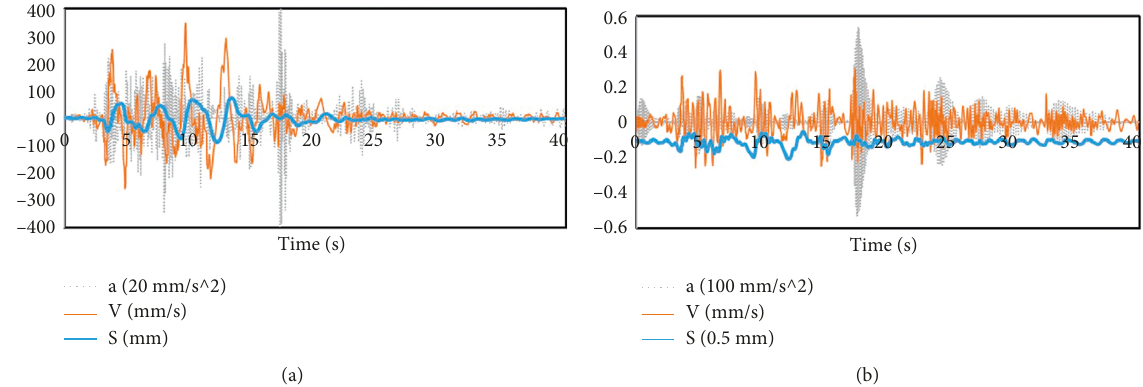
Figure 55: Time course curves of bearing deformation displacement, velocity and acceleration when N94 is input from X direction. (a) Horizontal deformation. (b) Vertical deformation.